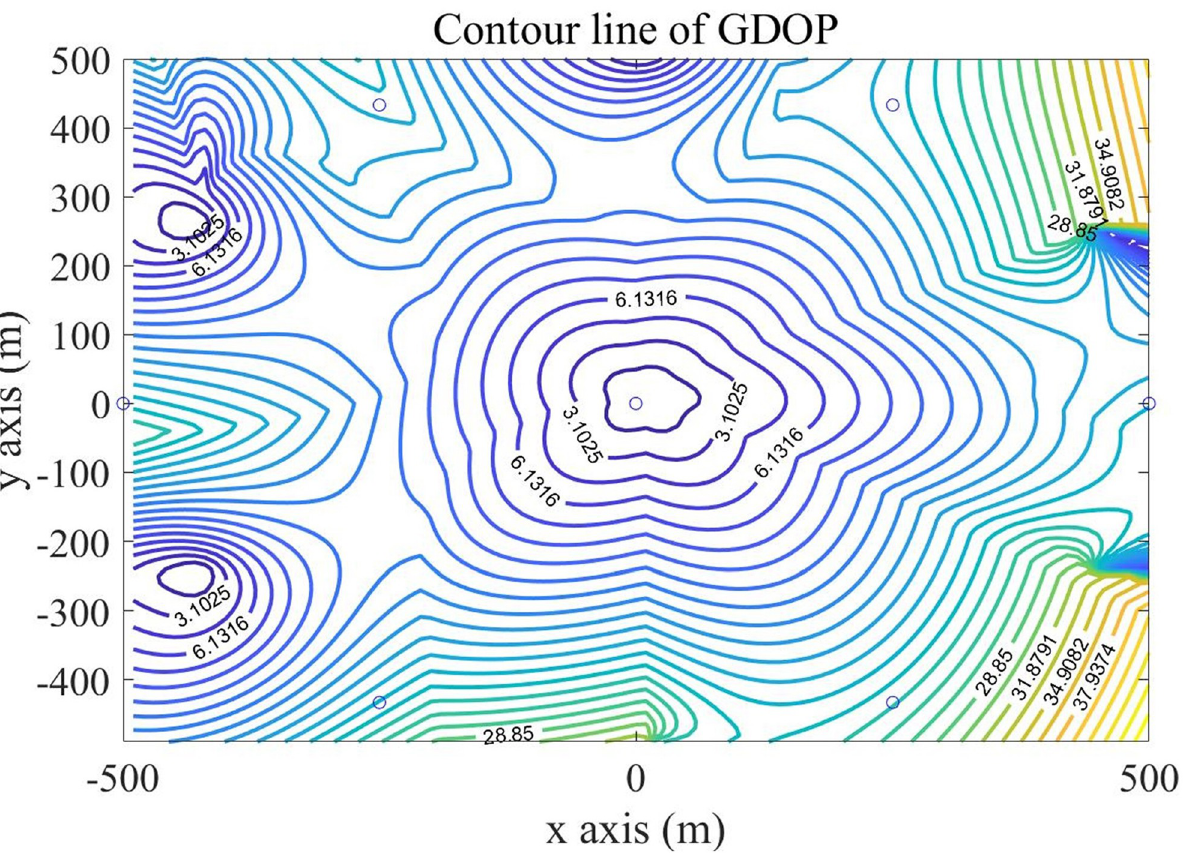
Fig 12. Contour lines of GDOP of five BSs using